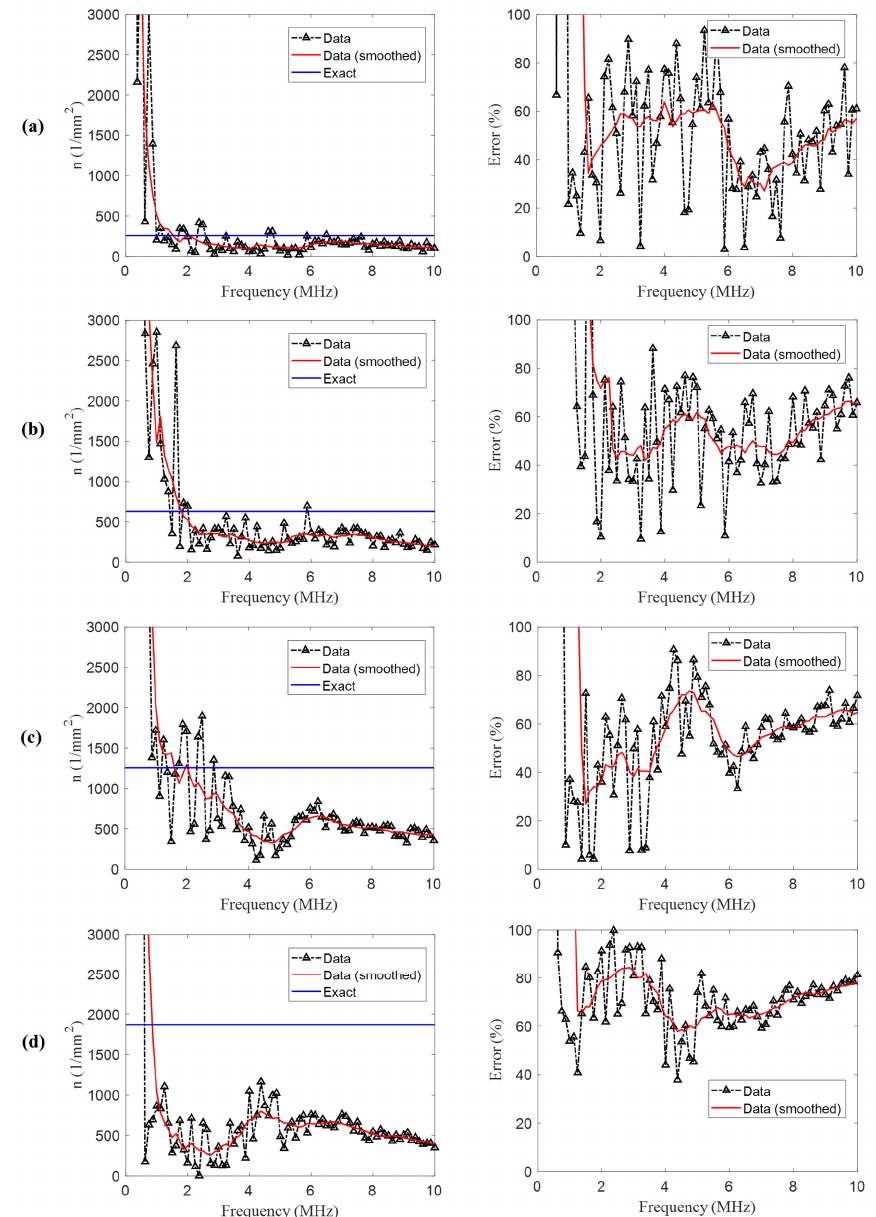
Figure 8. Number density estimation results ( left ) and estimation error ( right ) for different scatterer volume fractions: ( a ) 2%, ( b ) 5%, ( c ) 10%, and ( d ) 15%. ( a ) 2%, ( b ) 5%, ( c ) 10%, and ( d )